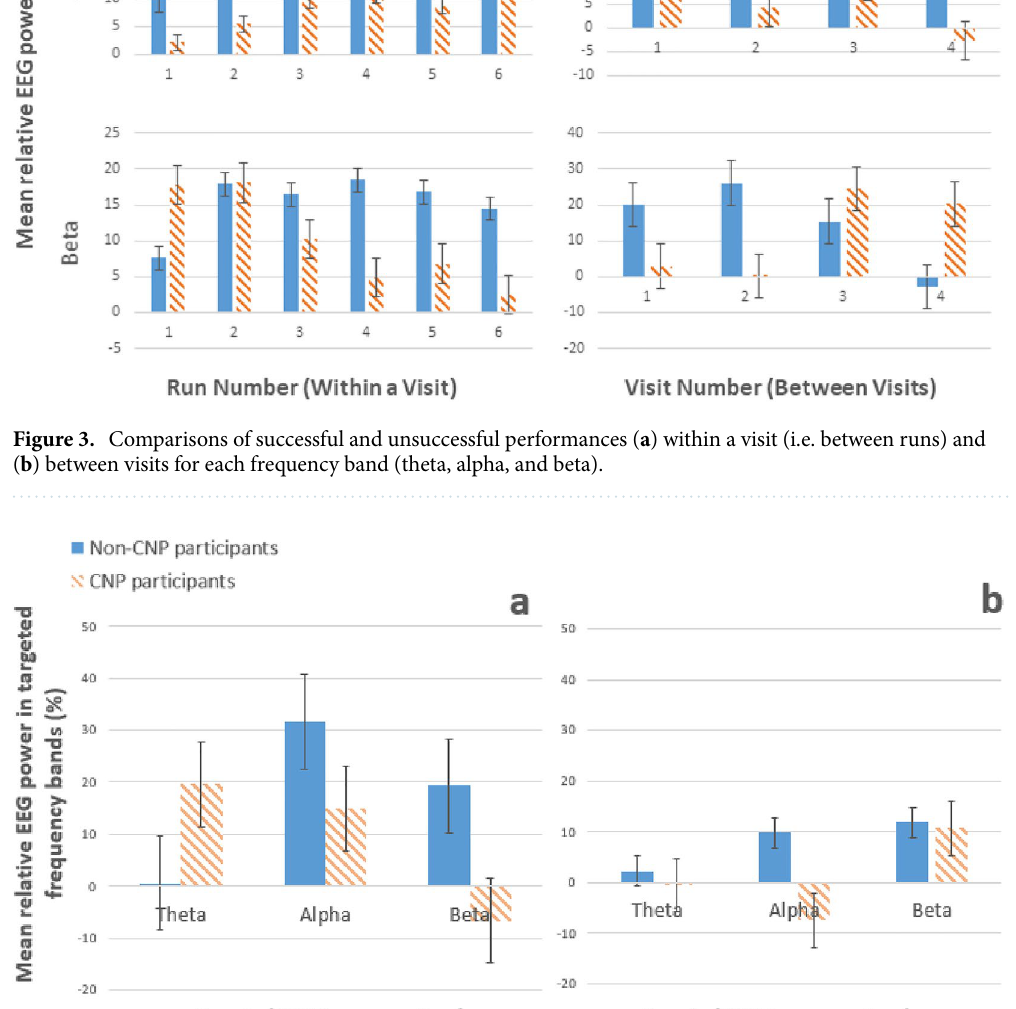
quency band are shown in Fig. 4. Not all participants completed all four neurofeedback training visits; reasons